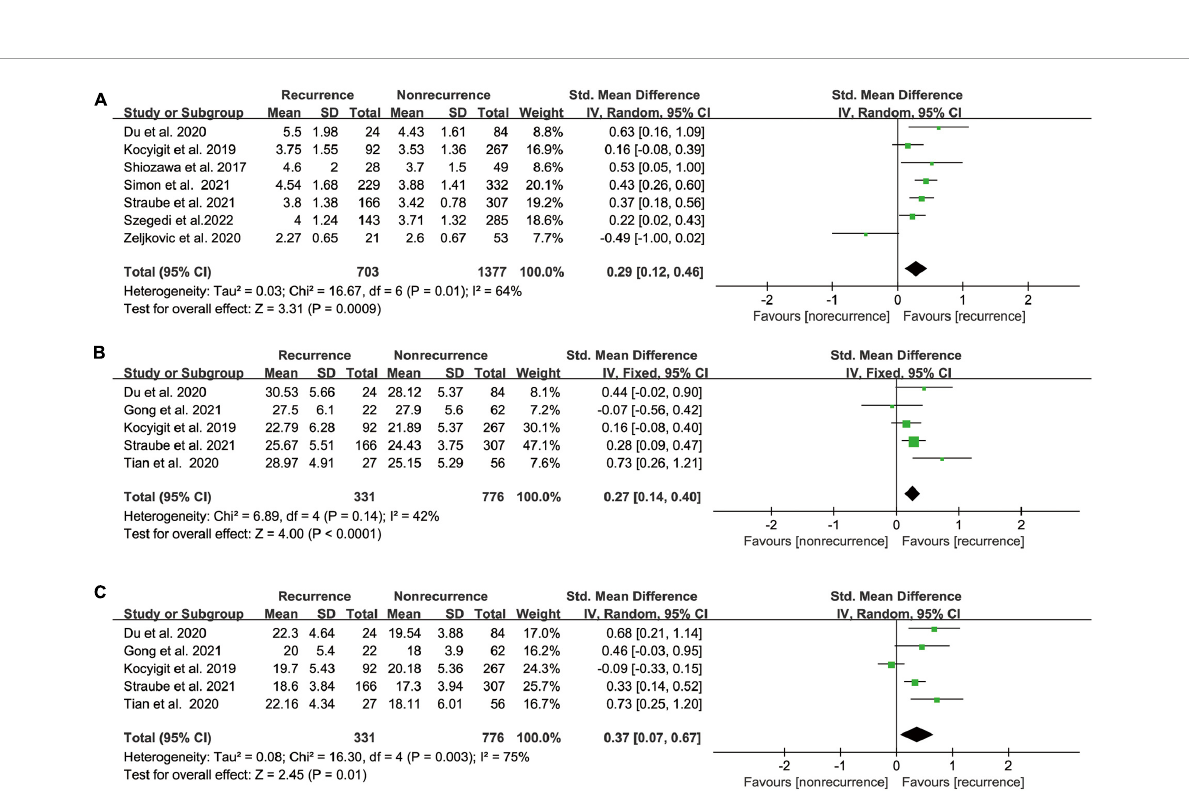
FIGURE5 (A) Forest plot showing the difference in LAA orifice area between patients with and without AF recurrence after catheter ablation. (B) Forest plot showing the difference in LAA orifice long axis between patients with and without AF recurrence after catheter ablation. (C) Forest plot showing the difference in LAA orifice short axis between patients with and without AF recurrence after catheter